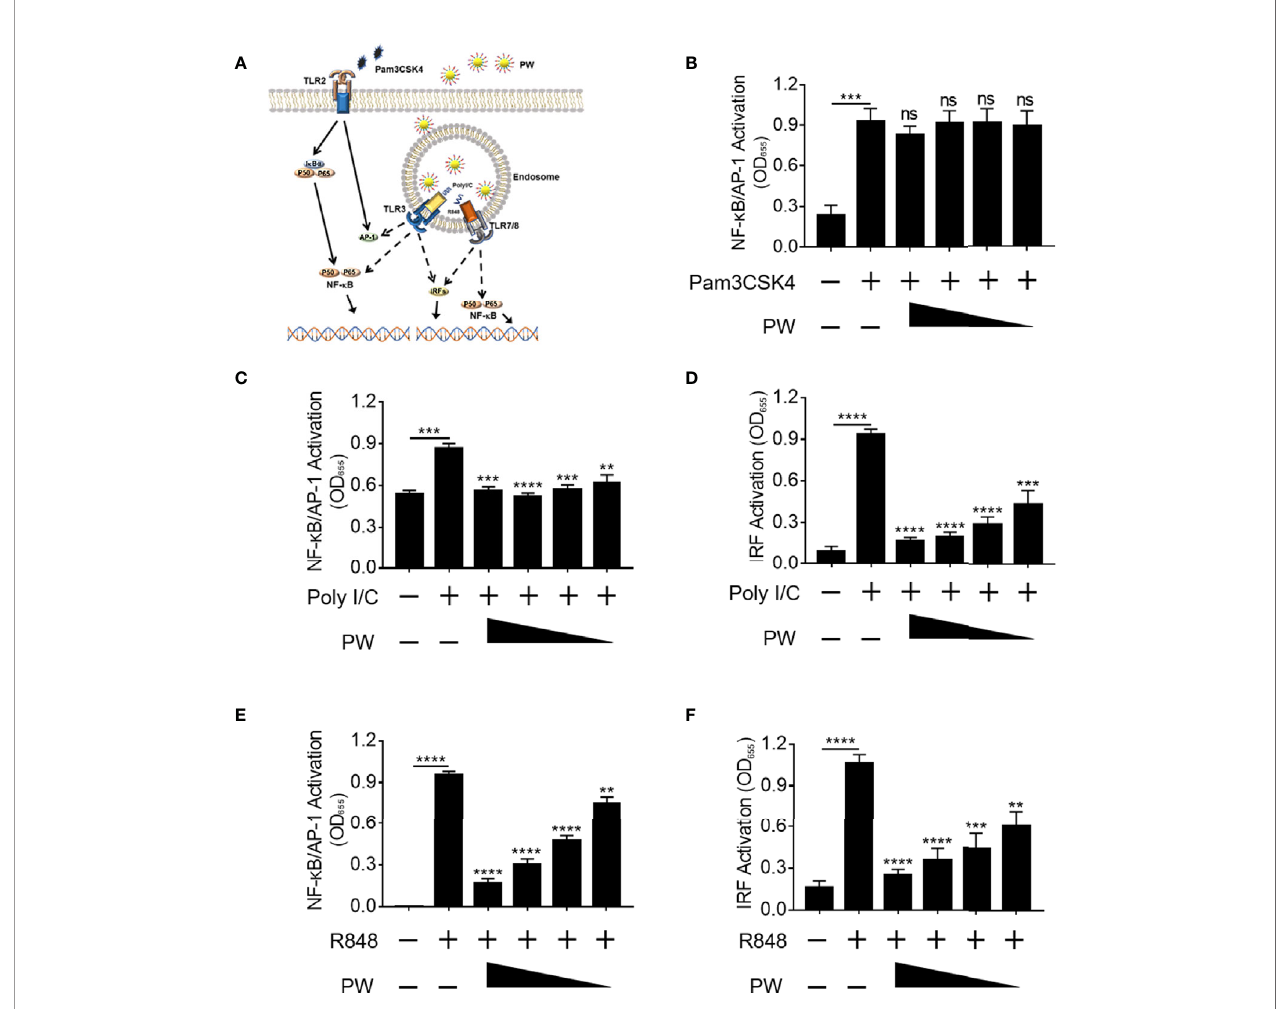
FIGURE 3 | Preferential inhibition of endosomal TLR signaling by PW in THP-1 reporter cells and their derived macrophages. (A) Illustration of the effects of PW on the cell surface TLR2 and the endosomal TLRs 3 and 7/8 signaling. (B) PW could not inhibit NF- k B/AP-1 activation induced by the TLR2 ligand Pam3CSK4 (10 ng/mL) in THP-1 reporter cell-derived macrophages. The inhibition of NF- k B/AP-1 (C) and IRF (D) by PW in TLR3 signaling stimulated by the Poly I/C (50 m g/mL) in THP-1 reporter cell-derived macrophages. The inhibitory effect of PW on the activation of NF- k B/AP-1 (E) and IRF (F) induced by the TLR7/8 ligand R848 (10 µg/mL) in THP-1 reporter cells. The concentrations of PW used: 200, 100, 50 and 25 nM; N ≥ 3, ns, not signi fi cant, **p < 0.01, ***p < 0.001, ****p <